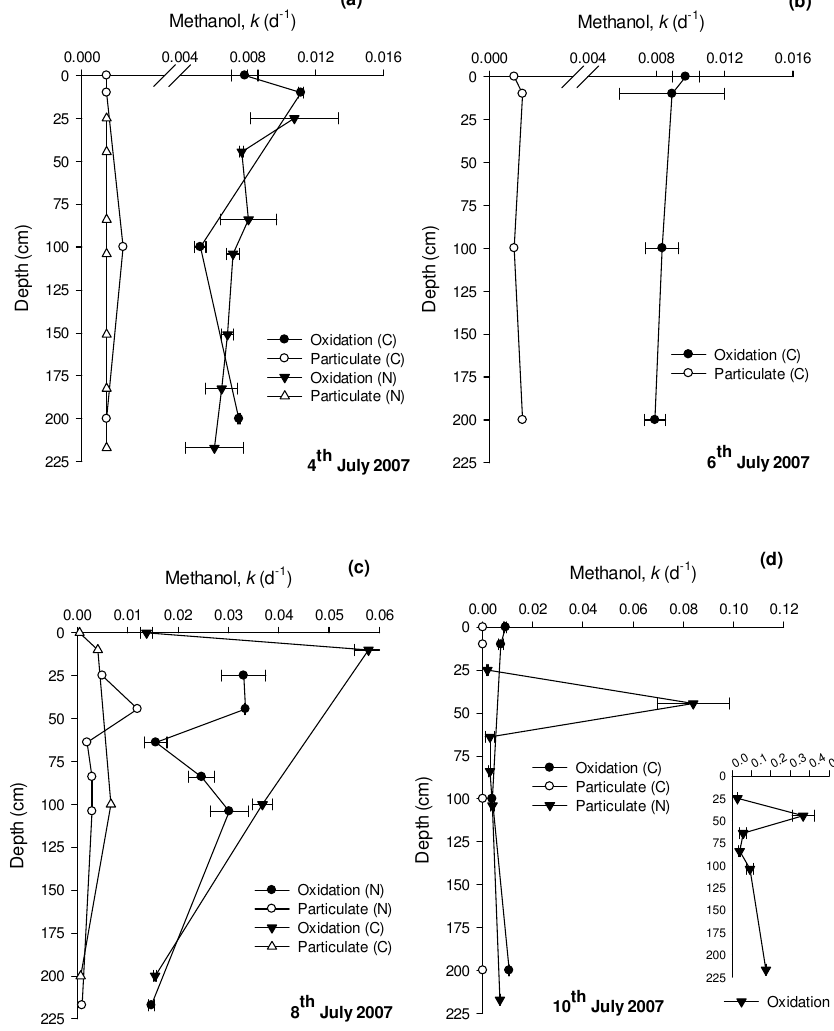
Fig. 2. Fine-scale variability in methanol oxidation and uptake into particles ( k) in the top 2m of the water column as sampled by either the Near-surface Sampling Device (N) or the Catamaran (C) for profiles sampled on (a) 4 July, (b) 6 July, (c) 8 July and (d) 10 July 2007. The error bars represent ± 1 standard deviation based on at least 3